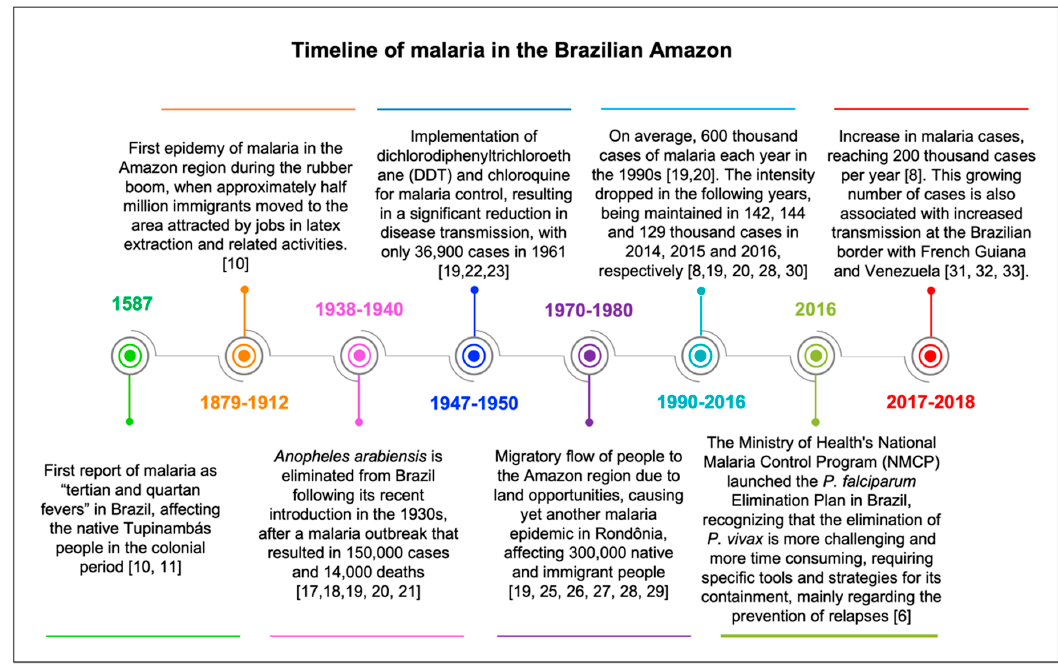
Figure 1. Timeline of the main events concerning malaria transmission and control in the Brazilian